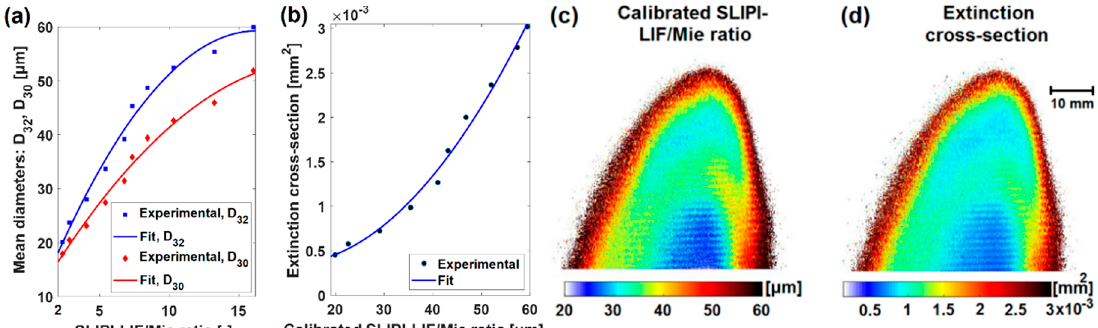
Figure 5. ( a ) The calibration curve of the SLIPI-LIF / Mie ratio plotted against droplet mean diameters, D 32 and D 30 . Both experimental data and calibration fit are given; ( b ) the calibration curve for the calibrated SLIPI-LIF / Mie ratio (SMD or D 32 ) plotted against droplet extinction cross-section. The droplet extinction cross-section is deduced from the Lorenz–Mie theory using the droplet size distribution histograms given in Figure 4e; ( c ) the calibrated SLIPI-LIF / Mie ratio showing the droplet SMD (for Z = 15 mm) is extracted by the calibration curve given in ( a ); ( d ) the droplets extinction cross-section map is extracted from the calibration curve shown in ( b ).